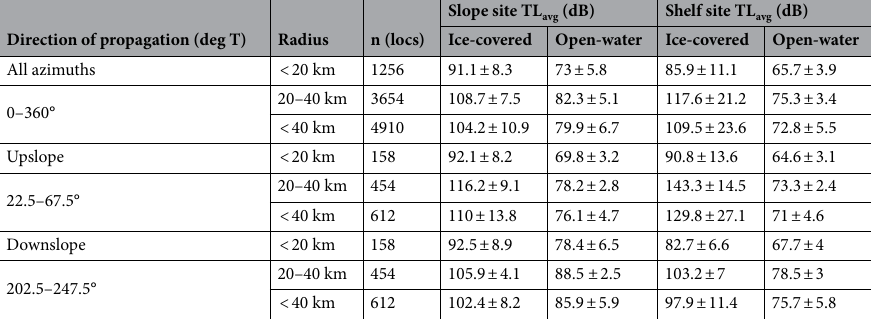
Table 1. Average modeled sound transmission loss (TL) for 80–180 Hz sounds traveling in all directions (All azimuths), toward shallower water (Upslope), and toward deeper water (Downslope) at the slope and shelf recording sites. Values are average and standard deviation of all 1 km 2 model locations within radii < 20 km, 20–40 km, and for all locations < 40 km. Number of locations included in statistical computation given as n(locs).